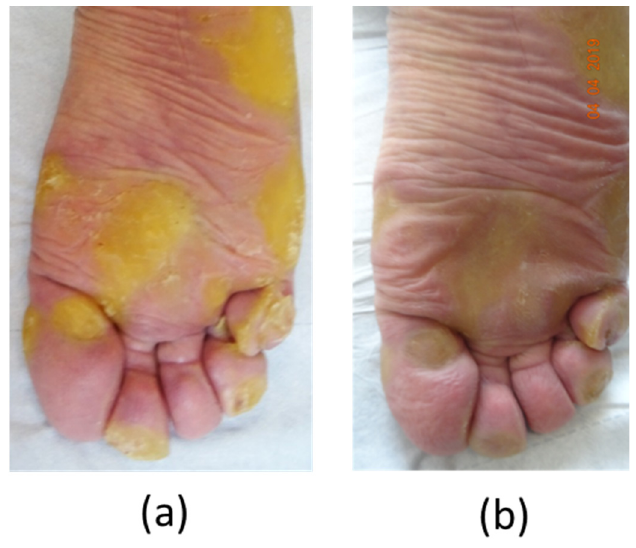
Figure 1. Evolution of plantar keratoderma in patient #1. ( a ) Skin lesions in patient #1 at day 0 before erlotinib treatment. ( b ) Hyperkeratosis reduction after 2 months of treatment.